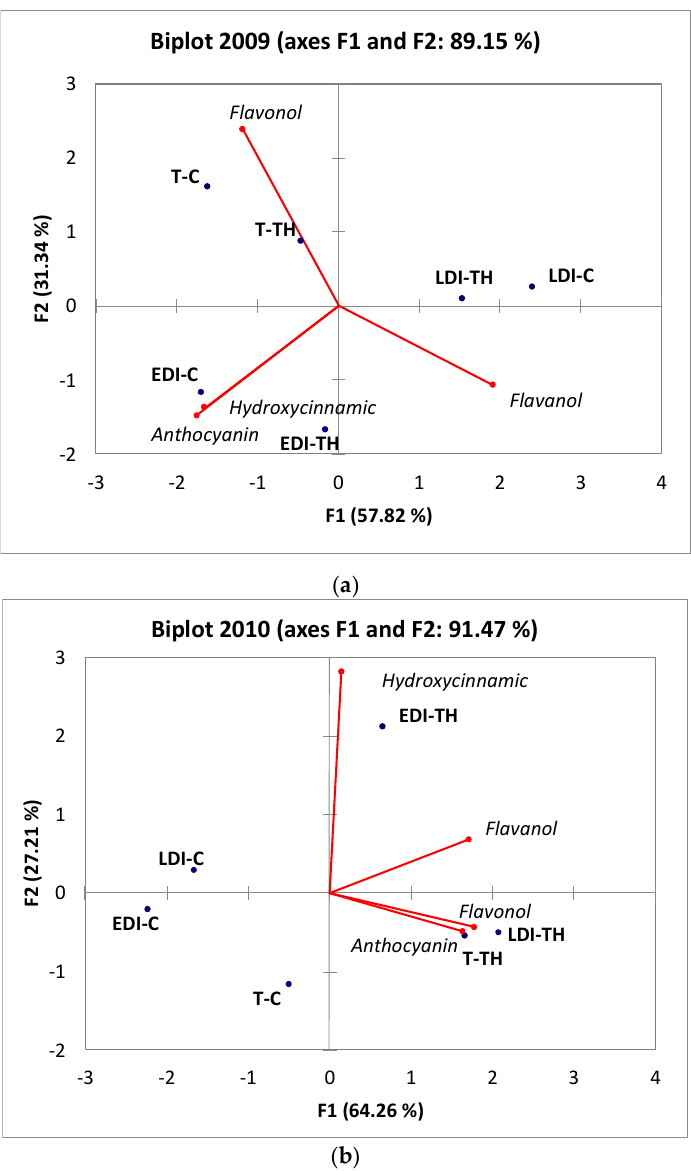
Figure 2. Principal component analysis results: ( a ) 2009 season; ( b ) 2010 season. T, rainfed; EDI and LDI, regulated deficit irrigation in pre- and post-veraison, respectively; C, control; TH, cluster thinning; RDI, regulated deficit irrigation; CL, crop load; C, control; TH, cluster thinning.